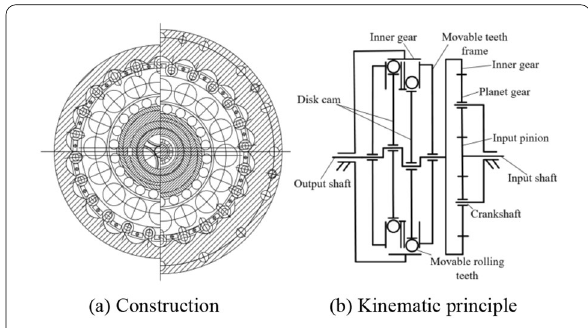
Figure 1 Construction and kinematic principle of CORR